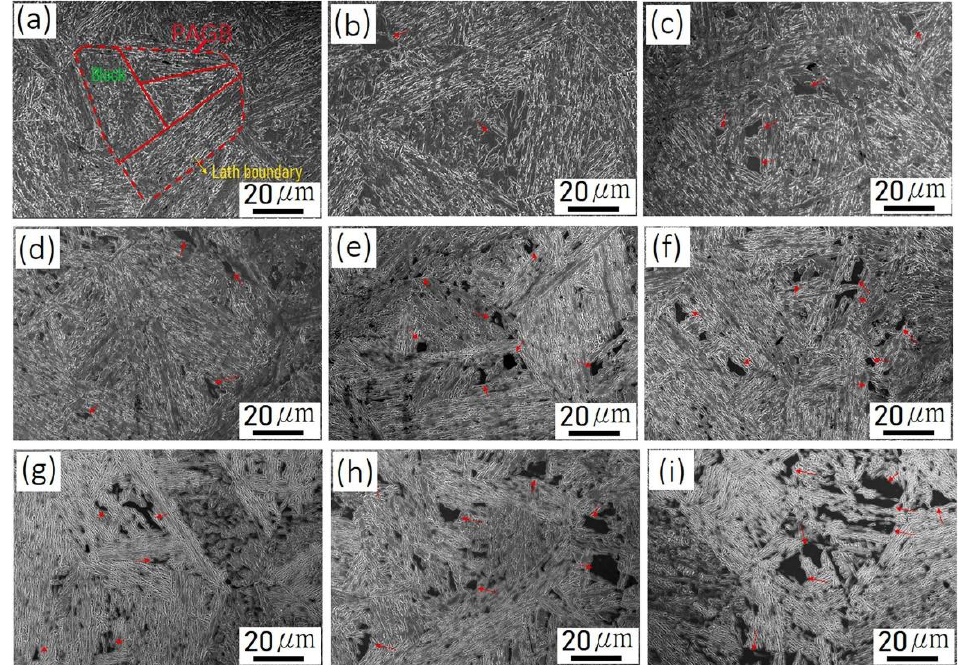
Figure 6. Hierarchical microstructures in Custom 465 steel aged at ( a – c ) 480 °C, ( d – f ) 560 °C, ( g – i ) 640 °C for ( a , d , g ) 1 h, ( b , e , h ) 4 h, and ( c , f , i ) 8 h, respectively. The reverted austenite within the martensitic matrix is marked by the red arrows [125]. (Reprinted with permission from Ref. [125]. Copyright 2022 Elsevier).